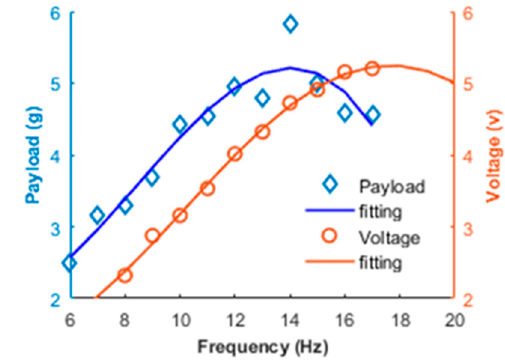
8 of 15 Figure 7. Lift and voltage variation versus time at 10 Hz. Combining the voltage data in Figure 7 and the Equation (16), we could get the root mean square (RMS) output voltage. The relationship of the mean lift force and RMS out- put voltage versus flapping frequency are shown in Figure 8. It can be seen from the fitting curves that the values of lift and voltage are proportional to the flapping frequency as the flapping frequency is below 14 Hz. Once flapping frequency exceeded the relative peak value, the payload and voltage value turned to a decreasing trend. This is because PVDF wing could not have enough time to finish the whole flapping motion in one cycle, which meant the PVDF wing was not able to accomplish the desired flapping amplitude. Due to complex deformation condition, it had a disturbance or counteraction phenomenon when the output signal had a different phase gradient of different bending the PVDF wing areas. These two factors collectively affected the increase trend of output voltage in high flap- ping frequency phase. As a result, it was important to choose an appropriate flapping frequency for PVDF wing application: 𝑈 (cid:3019)(cid:3014)(cid:3020) = (cid:2869) (cid:3015)(cid:3021) (cid:1516)